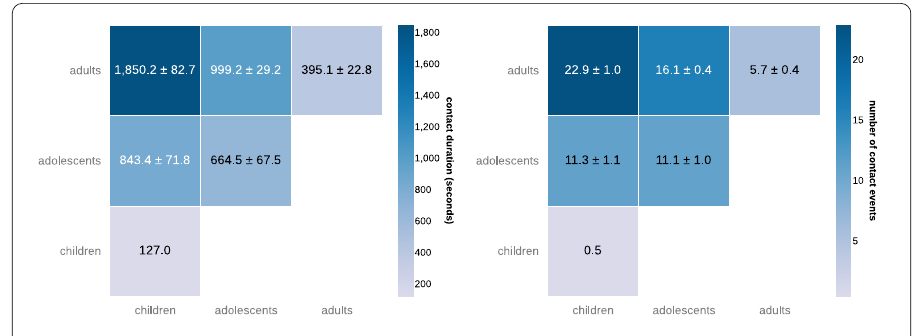
Figure 2 Intra-household contact matrices. Contact matrices giving the daily mean contact durations ( ± standard deviation) in seconds per capita (left panel) and the daily mean contact events ( ± standard deviation) per capita (right panel) by